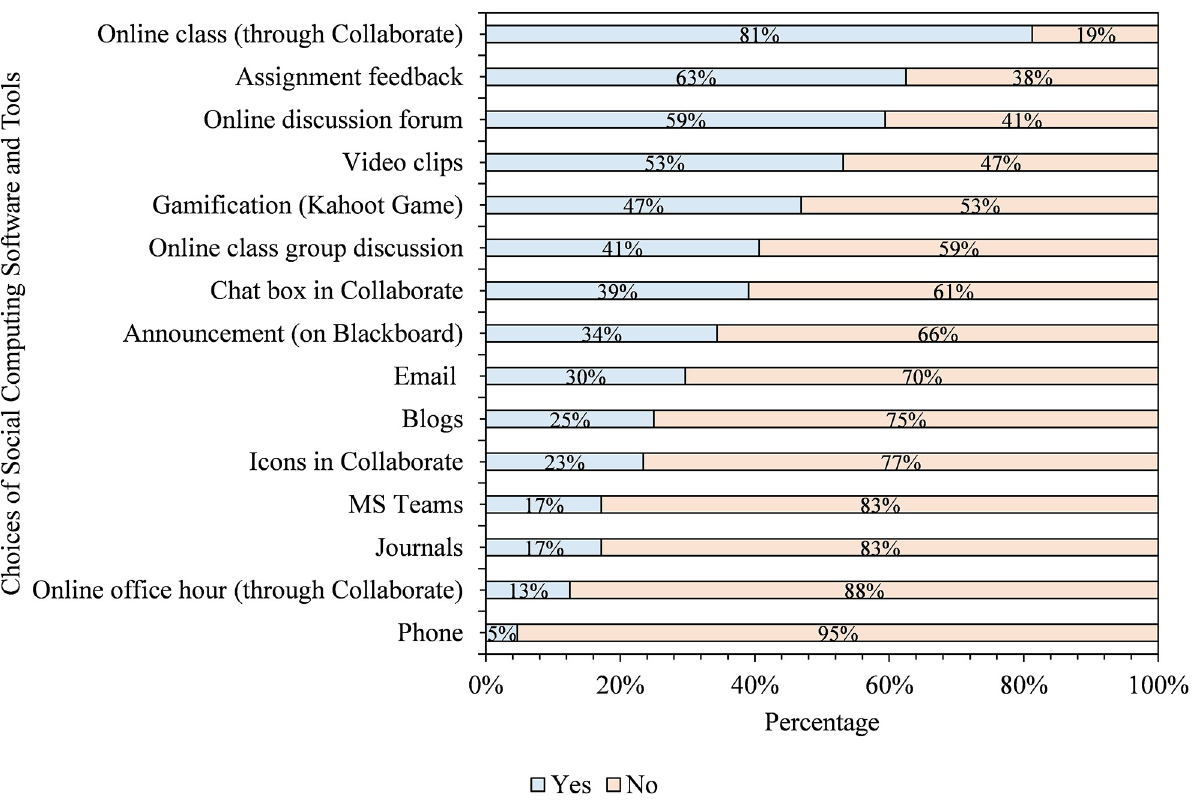
Fig 2. Students’ choices of social computing software and tools that helped them to learn in the course (n = 64).